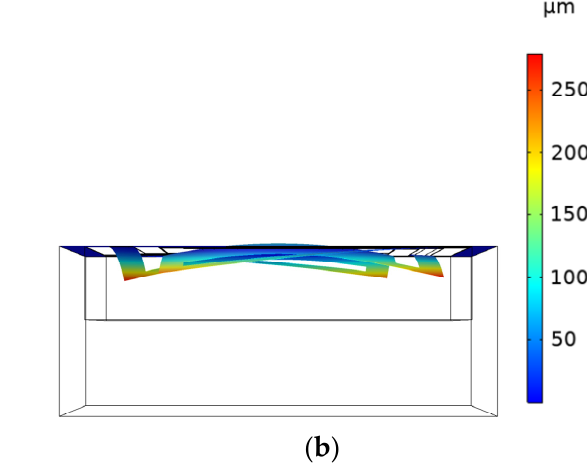
Figure 2. Cloud diagram of stress and deformation displacement simulation of the EELC model. ( a ) Cloud diagram of stress simulation; ( b ) cloud diagram of deformation displacement simulation .